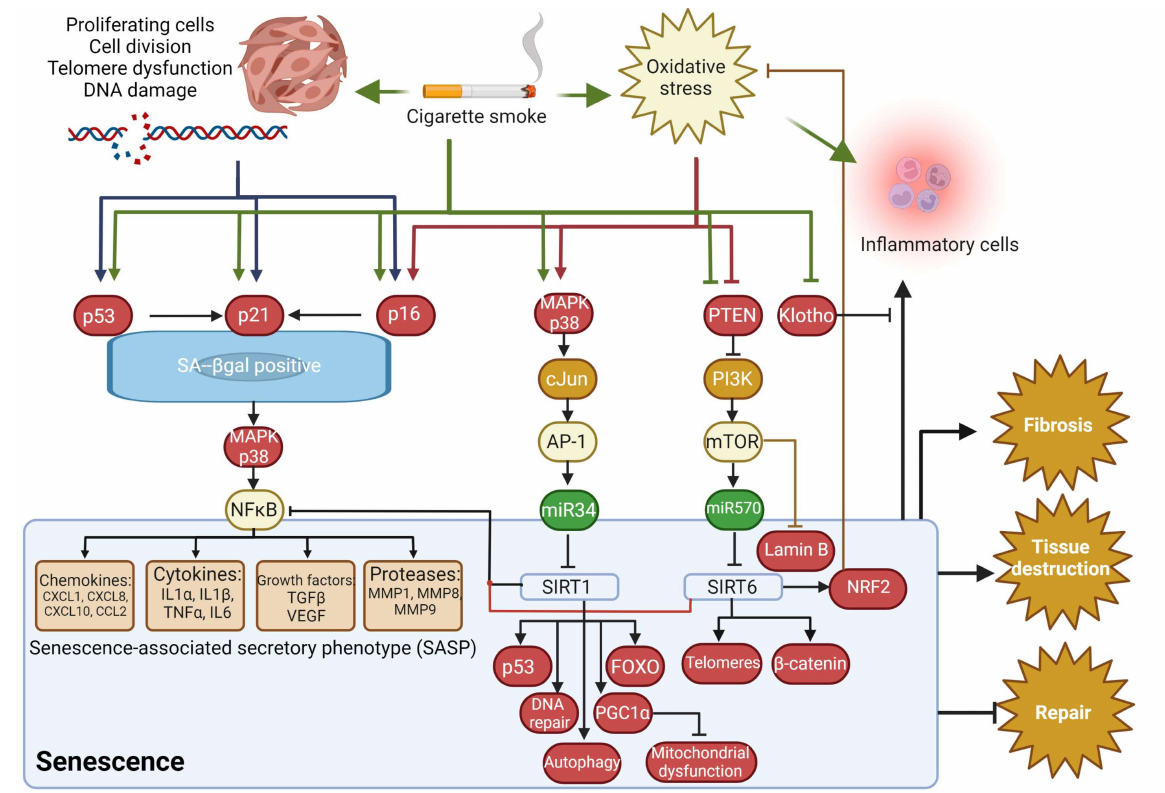
Figure 1. Possible mechanisms for senescence in COPD. Created with